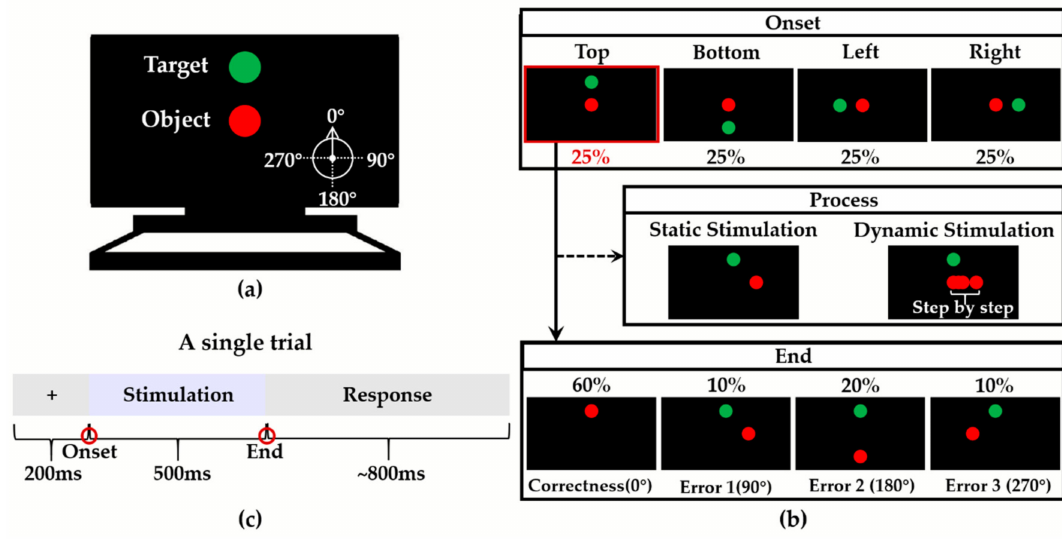
Figure 1. ( a ) Screen display at the onset of the experiment (the correct position: top); ( b ) Design